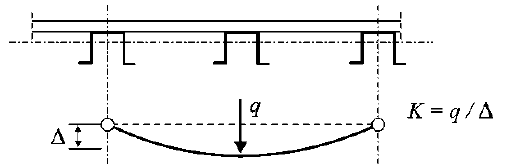
Fig. 8. Determination of sheathing stiffness at rib buckling